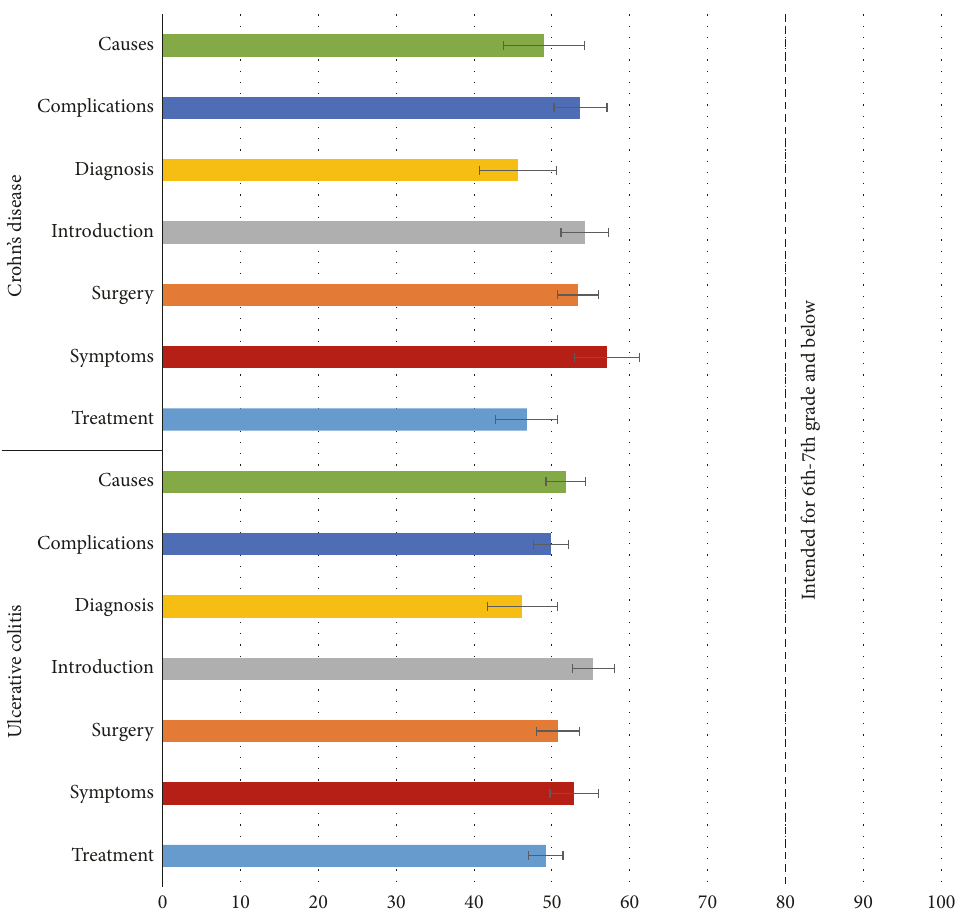
Figure 4: Assessment of text using FRE readability test. This figure depicts a bar graph with elevated reading grade level comprehension required for different subsections within the text. A score from 90 to 100 is intended for 11-year-old students and from 60 to 70 for 13–15- year-olds and a score from 0 to 30 is best understood by university graduates. Vertical axis at 𝑥 = 80 approximates to 6th-grade level of comprehension. FRE: Flesch Reading Ease; ACG: American College of Gastroenterology; CCFA: Crohn’s and Colitis Foundation of America; Mayo: Mayo Clinic; NIDDK: National Institute of Diabetes and Digestive and Kidney Diseases; UTD: UpToDate, Beyond the Basics; NHS: National Health Service; NYT: New York Times Health